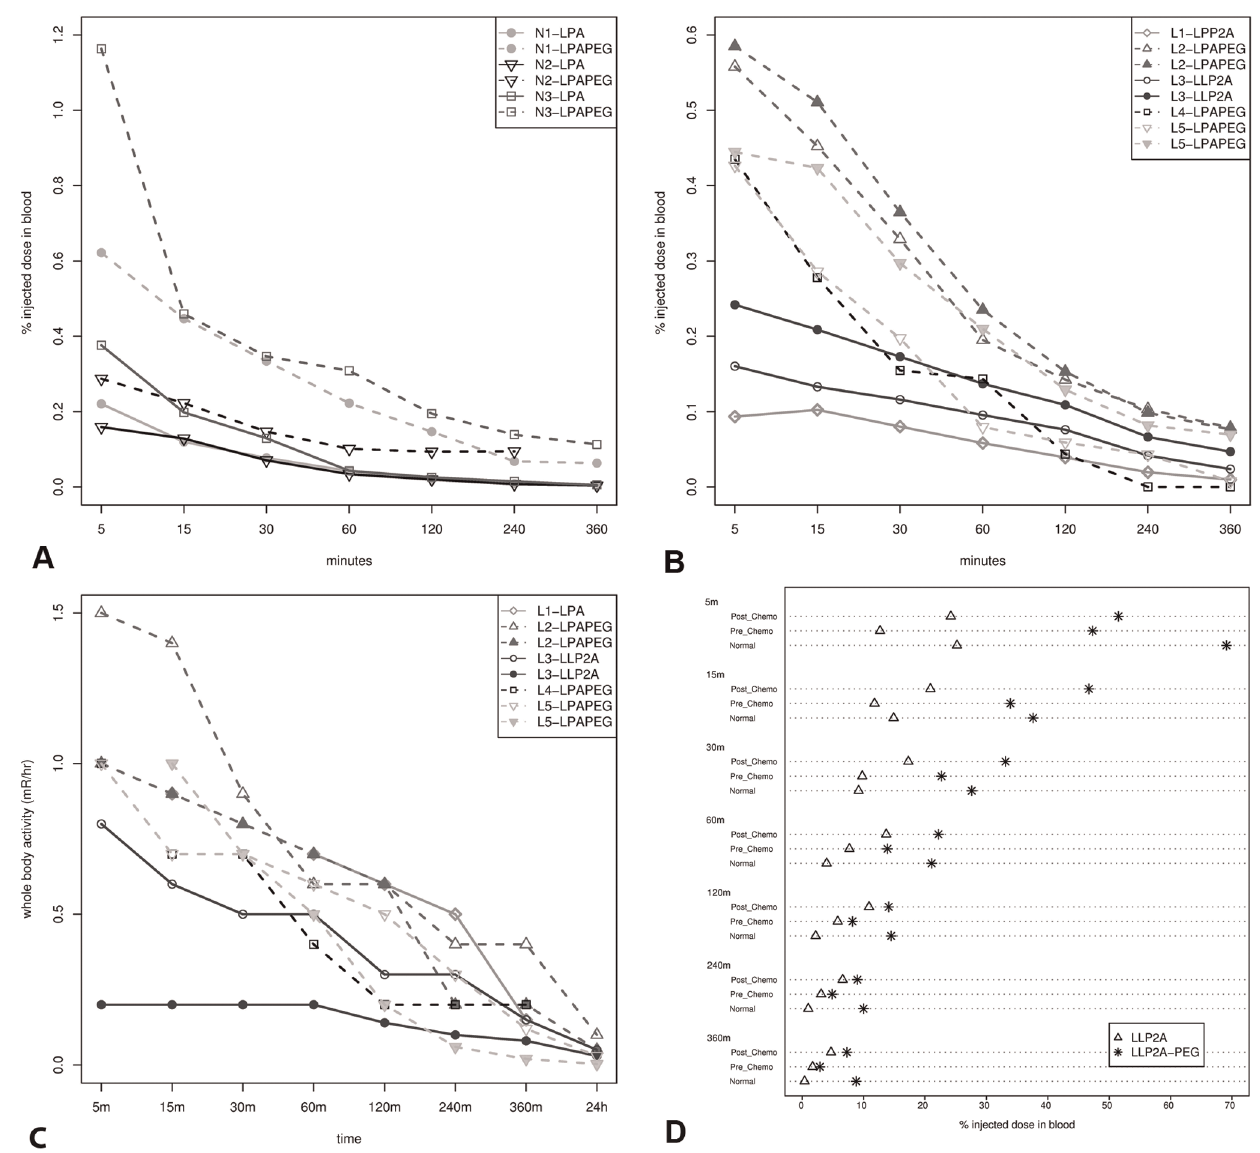
Figure 3. Blood clearance of 99m Tc-LLP2A-HYNIC and 99m Tc-LLP2A-HYNIC-PEG in dogs. Normal dogs (N1–N3) had higher % injected dose (PID) (A) than those with lymphoma (L1–L5) (B). In B and C, open symbols represent pre-chemotherapy and closed symbols represent post- chemotherapy status. In general 99m Tc-LLP2A-HYNIC-PEG had higher blood radioactivity than 99m Tc-LLP2A-HYNIC. (C). Whole body dose of dogs with lymphoma at 1 m declined to background levels by 24 hours after administration. (D). Mean Percent injected dose (PID) of 99m Tc-LLP2A-HYNIC (triangles) and 99m Tc-LLP2A-HYNIC-PEG (stars) in blood over time for pre- and post-chemotherapy lymphoma dogs and in normal dogs.